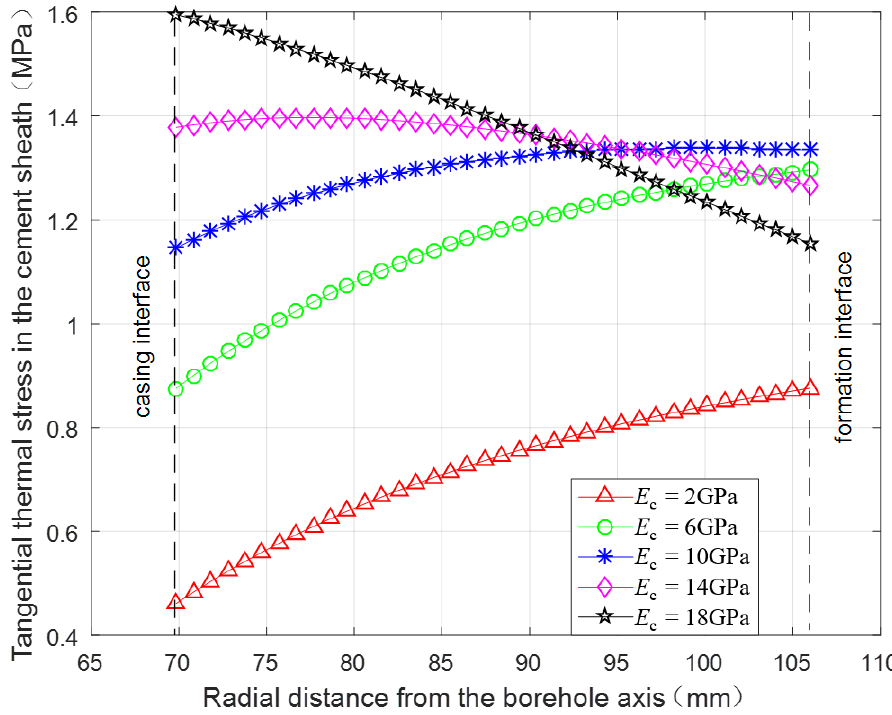
Figure 14. Radial distribution of the tangential thermal stress in the cement sheath under different elasticity moduli of the cement sheath.